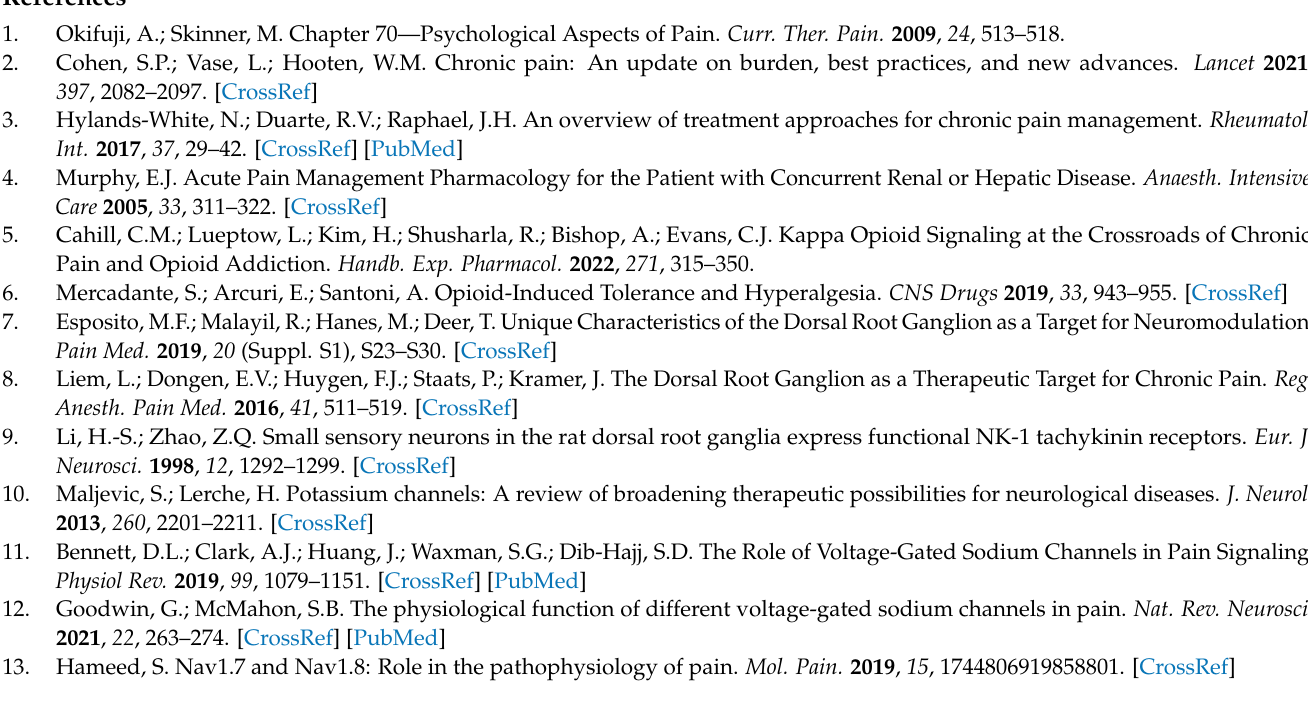
Figure S3: 1 H NMR spectrum of ( − )-NRG-DM (400 MHz, CDCl 3 ); Figure S4: 13 C NMR spectrum of ( − )-NRG-DM (100 MHz, CDCl 3